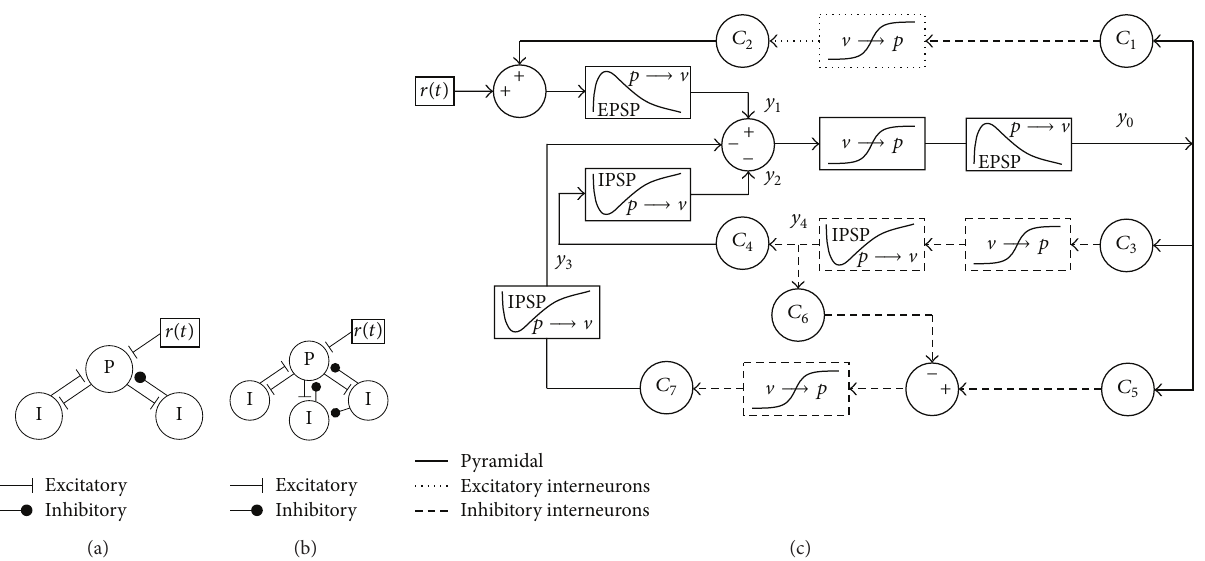
Figure 1: Core models. (a) Initial model [10] showing pyramidal (P) and interneuron (I) subgroups with either excitatory or inhibitory projections. 𝑟(𝑡) is a random input. (b) Extended model [18]. (c) Detailed diagram of computational components for pyramidal cells (solid lines), excitatory interneurons (dotted lines), and inhibitory interneurons (dashed lines). Pulse-to-voltage blocks are labeled “ 𝑝 → V ”, and voltage-to-pulseblocksarelabeled“ V → 𝑝 ”.TheIPSPblockisdistinguishedfromtheEPSPblocksbyawaveformshowingnegativedeflection. Table 1: Model parameters from Wendling et al. [18].